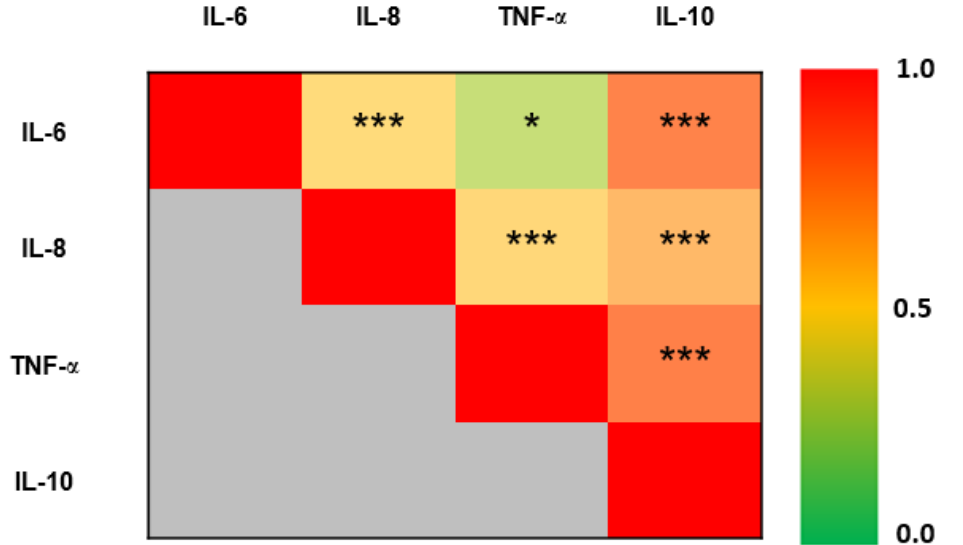
Figure 1. Heatmap representing significant positive correlations among cytokines measured in the whole cohort ( n = 80). Correlation coefficient range (0–1) is color-coded (green to red). Correlations were made using Spearman’s correlation analysis (* p ≤ 0.05, *** p ≤ 0.001). IL-6 and IL-10 were elevated in higher intensity sports in an age-dependent manner: When comparing levels of detected cytokines among different sport intensities, there were significant elevations in IL-6 ( p = 0.02) and IL-10 ( p = 0.03) with increased sport